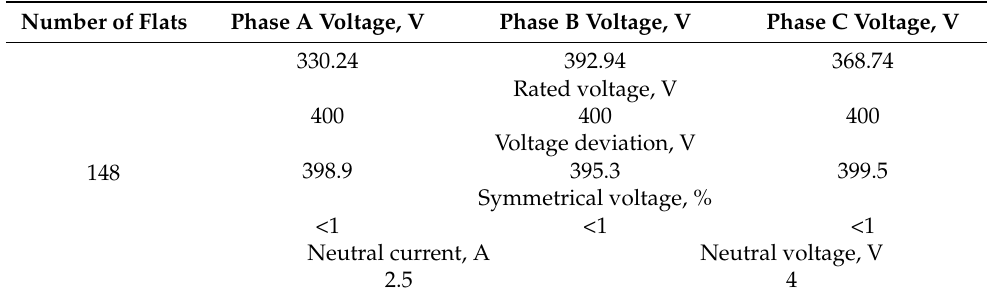
Table 6. Grid operation parameters of the urban distribution grid model after adding the voltage symmetrization